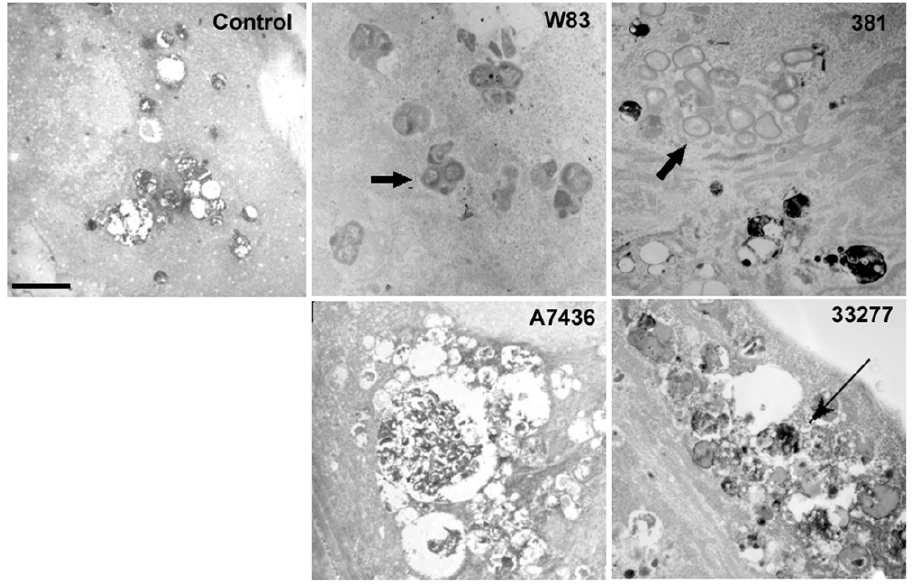
Figure 3. Ultrastructural evaluation of internalized P.gingivalis at 6 hours post-inoculation. Transmission electron microscopic images (6000 6 magnification) of uninfected (control) and infected cells are representative of 3 independent experiments. Block arrows indicate internalized bacteria in CMPase negative vacuoles. Thin arrow depicts bacteria undergoing degradation within CMPase positive vacuoles. Scale bar represents 2 m m.